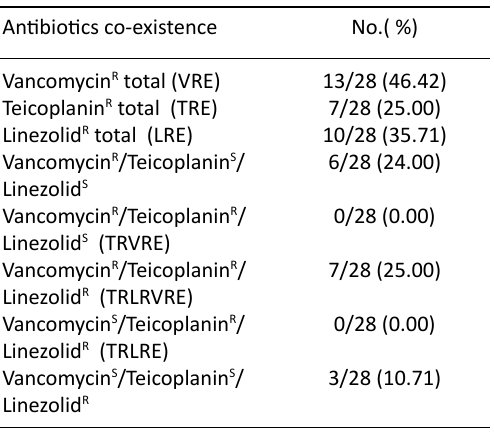
Table 2. Co-existence resistance among Enterococcus spp.